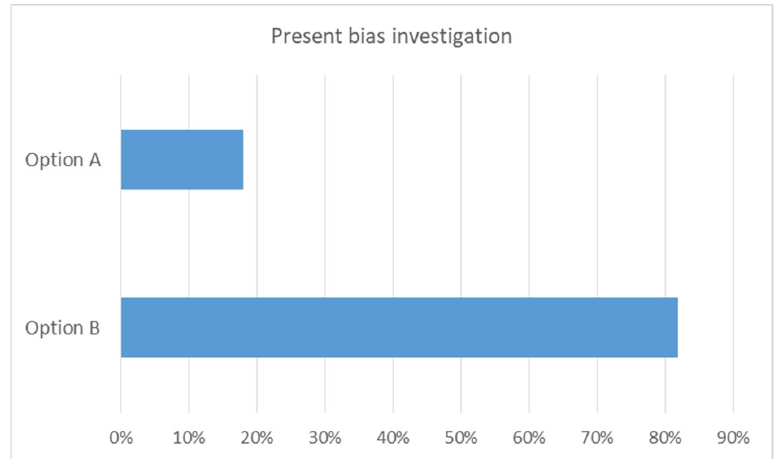
Figure 6. Investigating present bias among respondents.